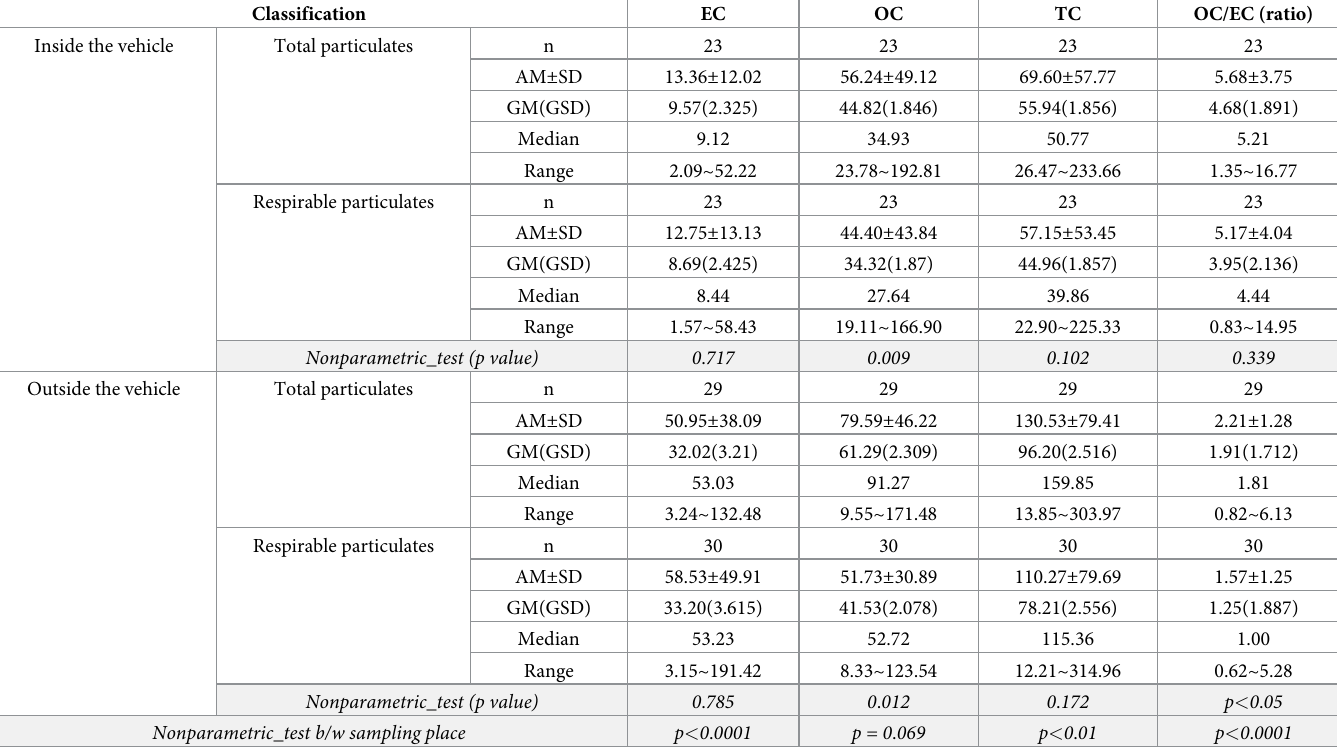
Table 2. Concentration of EC, OC, TC in underground excavation work ( μ g/m 3 ). Classification